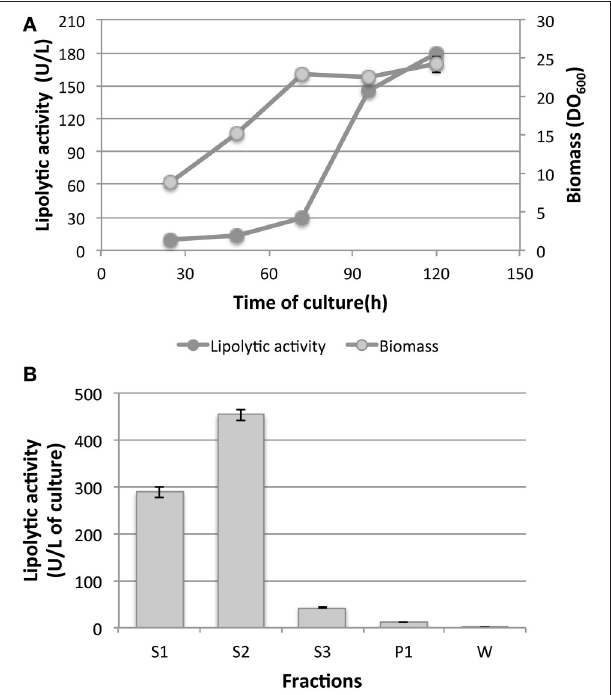
FIGURE 9 | Production of LOB4Est: (A) Biomass and extracellular lipolytic activity of a culture of the strain Sc-LOB4Est in YPHSM. (B) Lipolytic activity in different cellular fractions of a culture of the strain Sc-LOB4Est in YPHSM. S1: extracellular, S2: periplasm, S3: cytoplasm, P1: cellular debris, W: washes. Data show mean ± standard deviation. N = 3